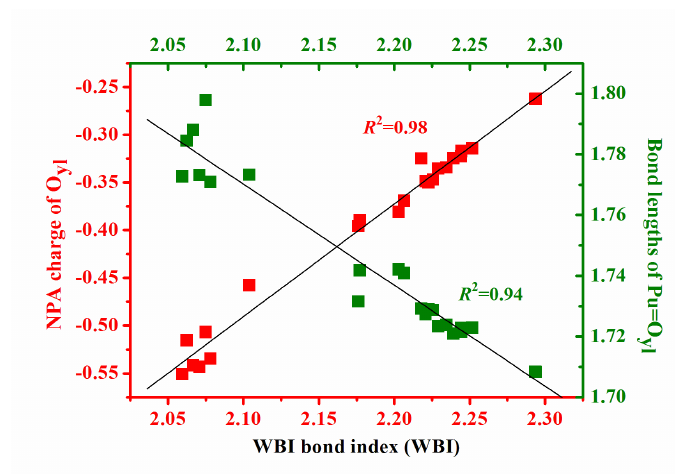
Figure 2. The linear correlation between WBI values and Pu–O yl bond lengths and NPA charge of O yl atoms in plutonyl moetiy.